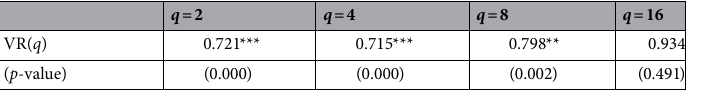
Table 2. VR test results on the log price series of Bitcoin. Variance ratios for holding periods 2, 4, 8, and 16 are tested under the homoscedasticity assumption. ** and *** indicate significance at the 1% and 0.1% levels, respectively.